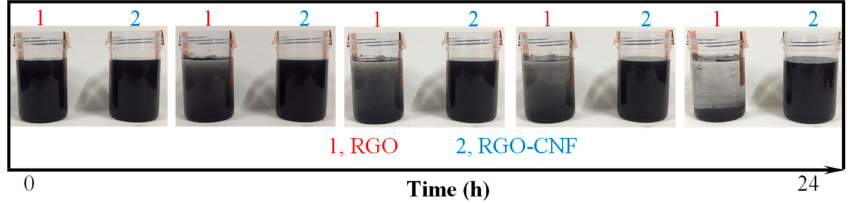
Figure 2. Comparison of graphene oxide (RGO) and RGO–cellulose nanofiber (CNF) aqueous suspensions with static treatment for 24 h.